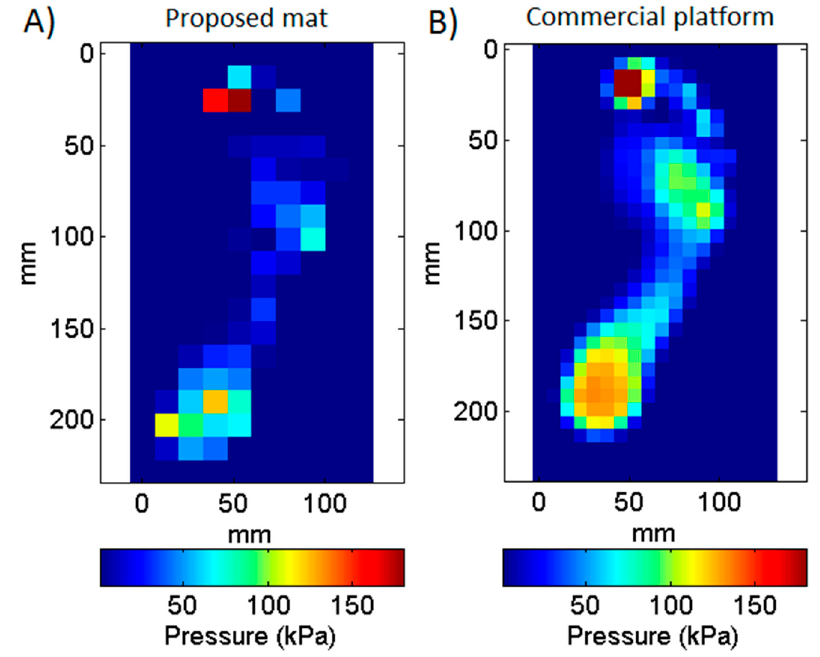
Figure 10. Comparison between two average plantar pressure maps acquired simultaneously with the proposed mat ( A ) and the commercial platform ( B ) during a unipedal standing trial. Maps represent the average pressure during a 30 s acquisition.